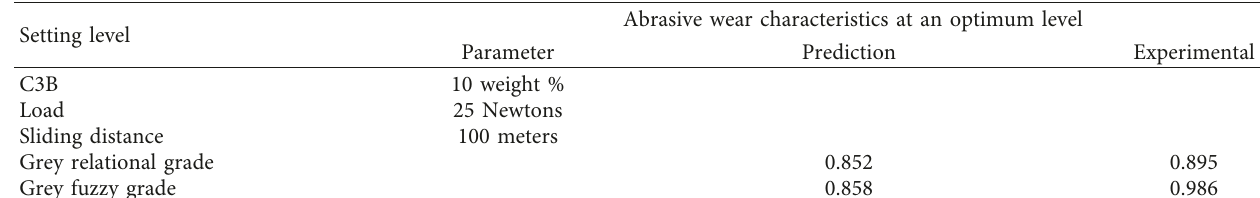
Figure 8: Main effect plots for the grey fuzzy grade. Table 6: Confirmation test